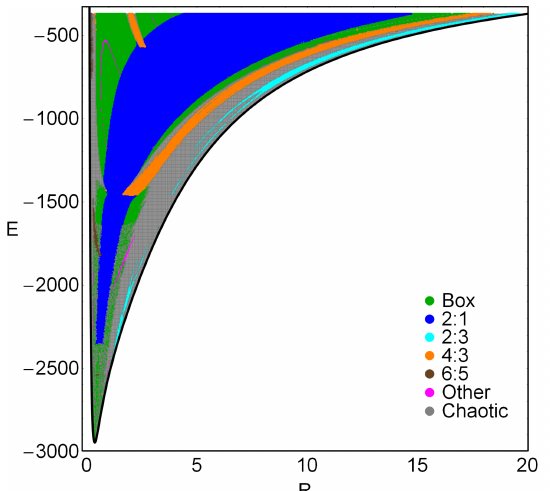
Fig. 4. Orbital structure of the ( R; E ) plane showing a detailed analysis of the evo- lution of orbits starting perpendicularly to the R -axis when the value of energy varies in the interval E 2 [ (cid:0) 2946 ; (cid:0) 371].